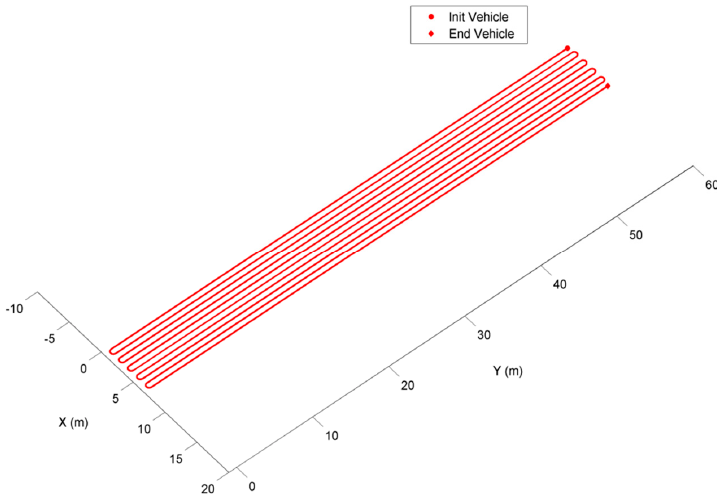
Figure 2. Path taken by the planner traversed all rows of the crop field in which the experiments were performed.